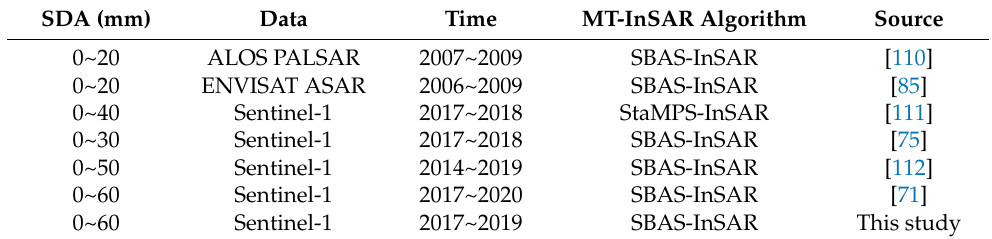
Table 5. Comparison with the previous results in the study